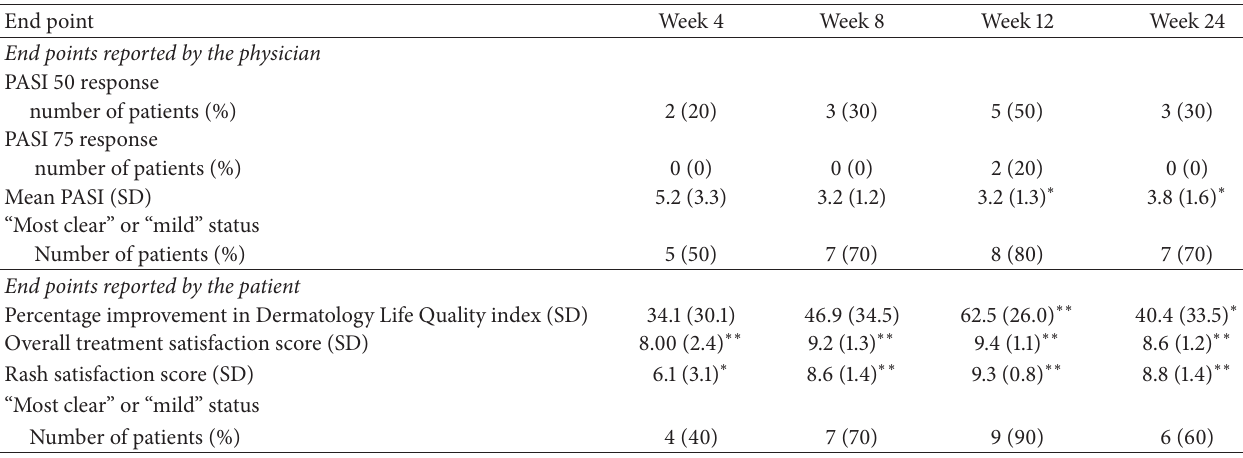
Table 3: Clinical responses at weeks 4, 8, 12, and